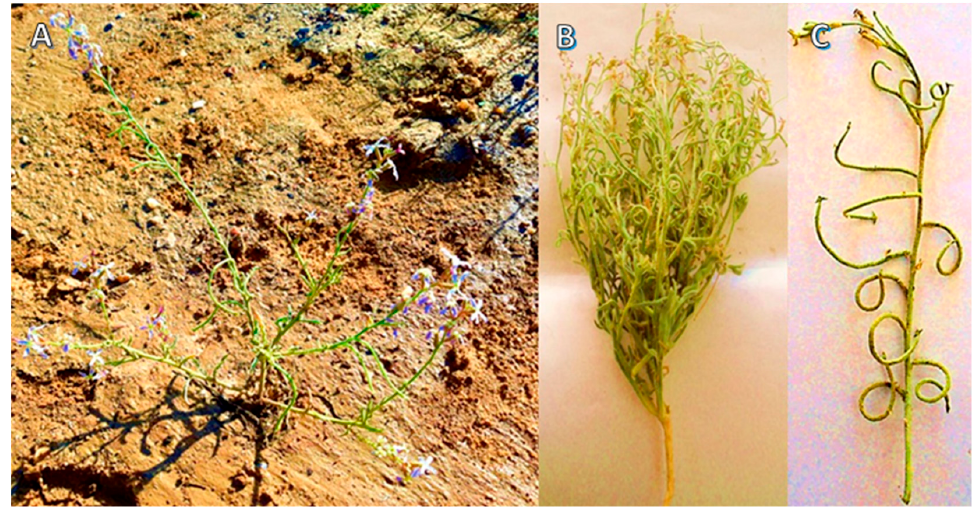
Figure 1. Overview of Matthiola longipetala DC. ( A ), flowering plant ( B ), and fruiting branches with legumes ( C ).